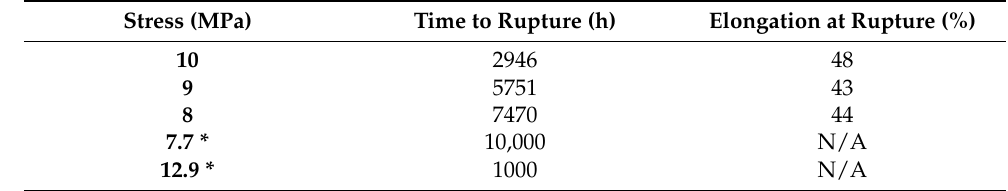
Table 3. Creep data showing the time to rupture and elongation for different stress levels. Stress (MPa) Time to Rupture (h)